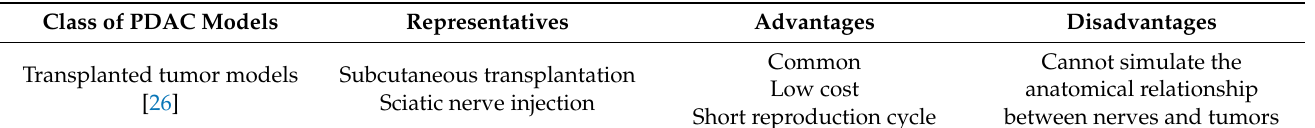
Table 1. Reported animal models in studying the crosstalk between PDAC and nerves.